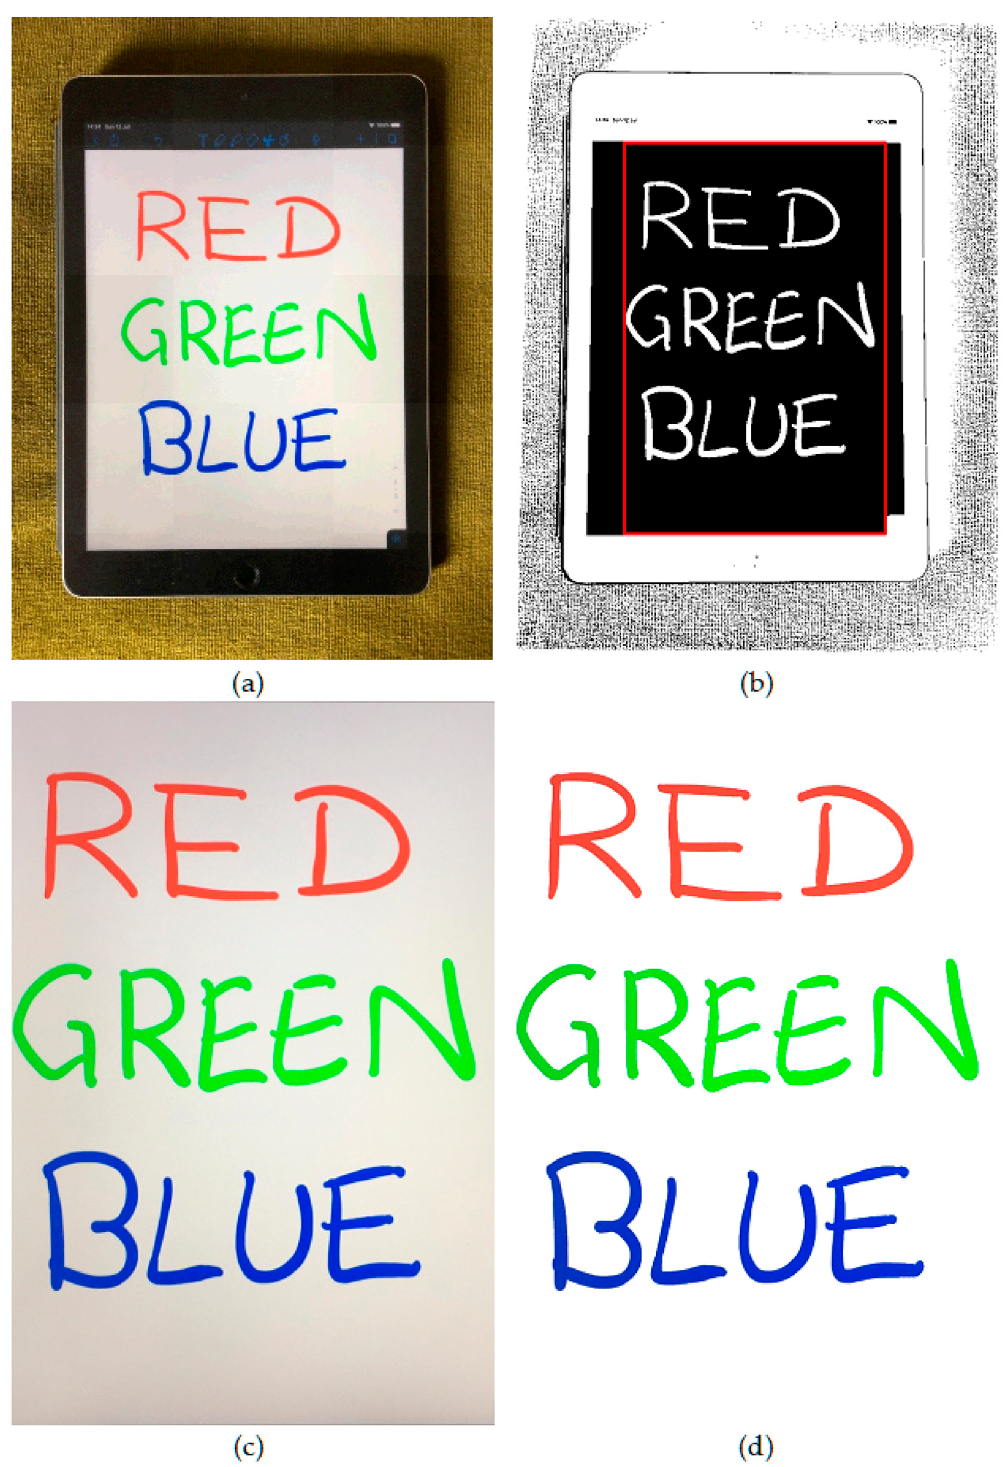
Figure 1. Stages of CleanPage. ( a ) A sample image from the original image sequence; ( b ) the binary surface mask showing the border search box; ( c ) the merged image after border removal; ( d ) after